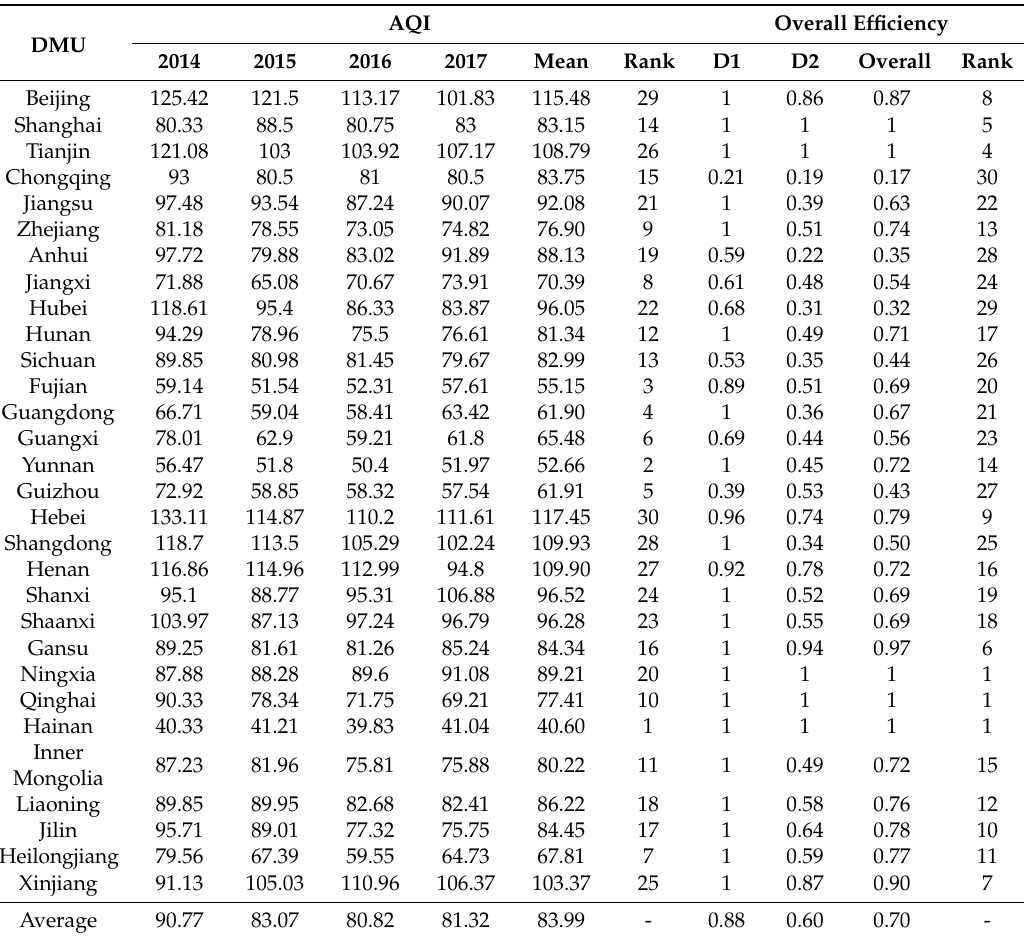
Table 5. AQI of China’s provinces within the period